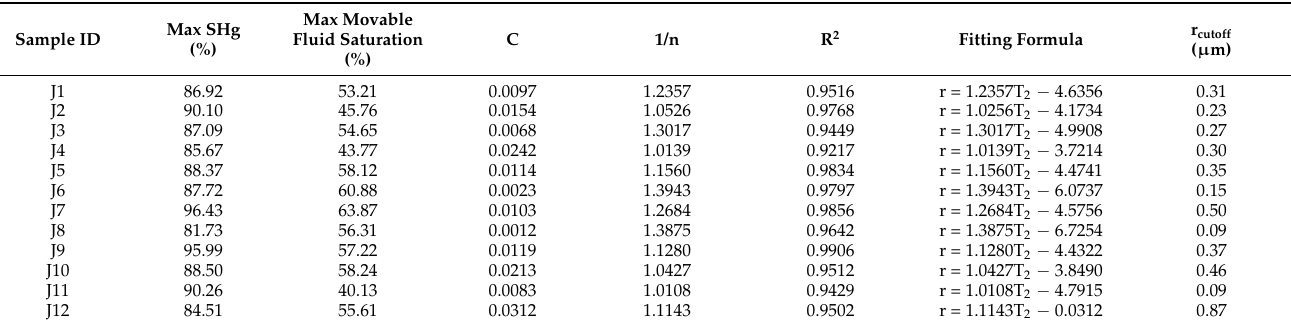
Table 7. Conversion factors between the NMR T 2 spectrum and pore–throat radius and the corre- sponding correlation